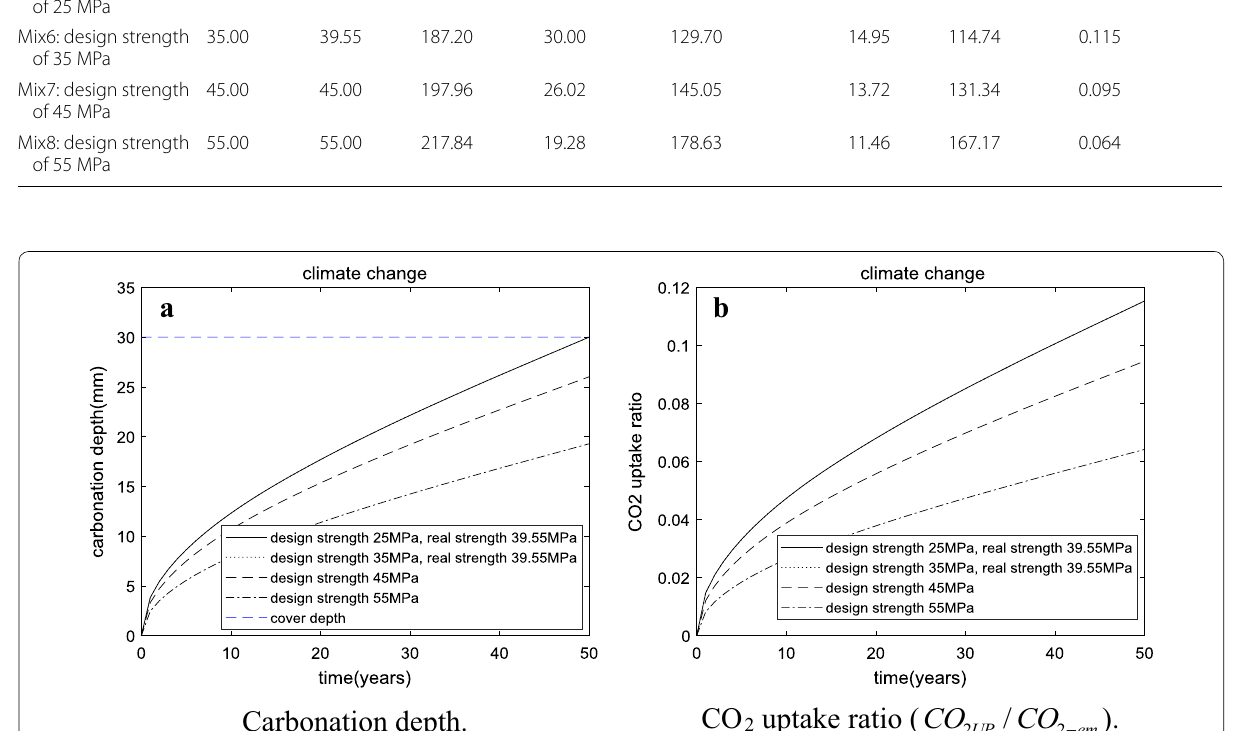
Fig. 5 Carbonation depth and CO 2 uptake under a climate change